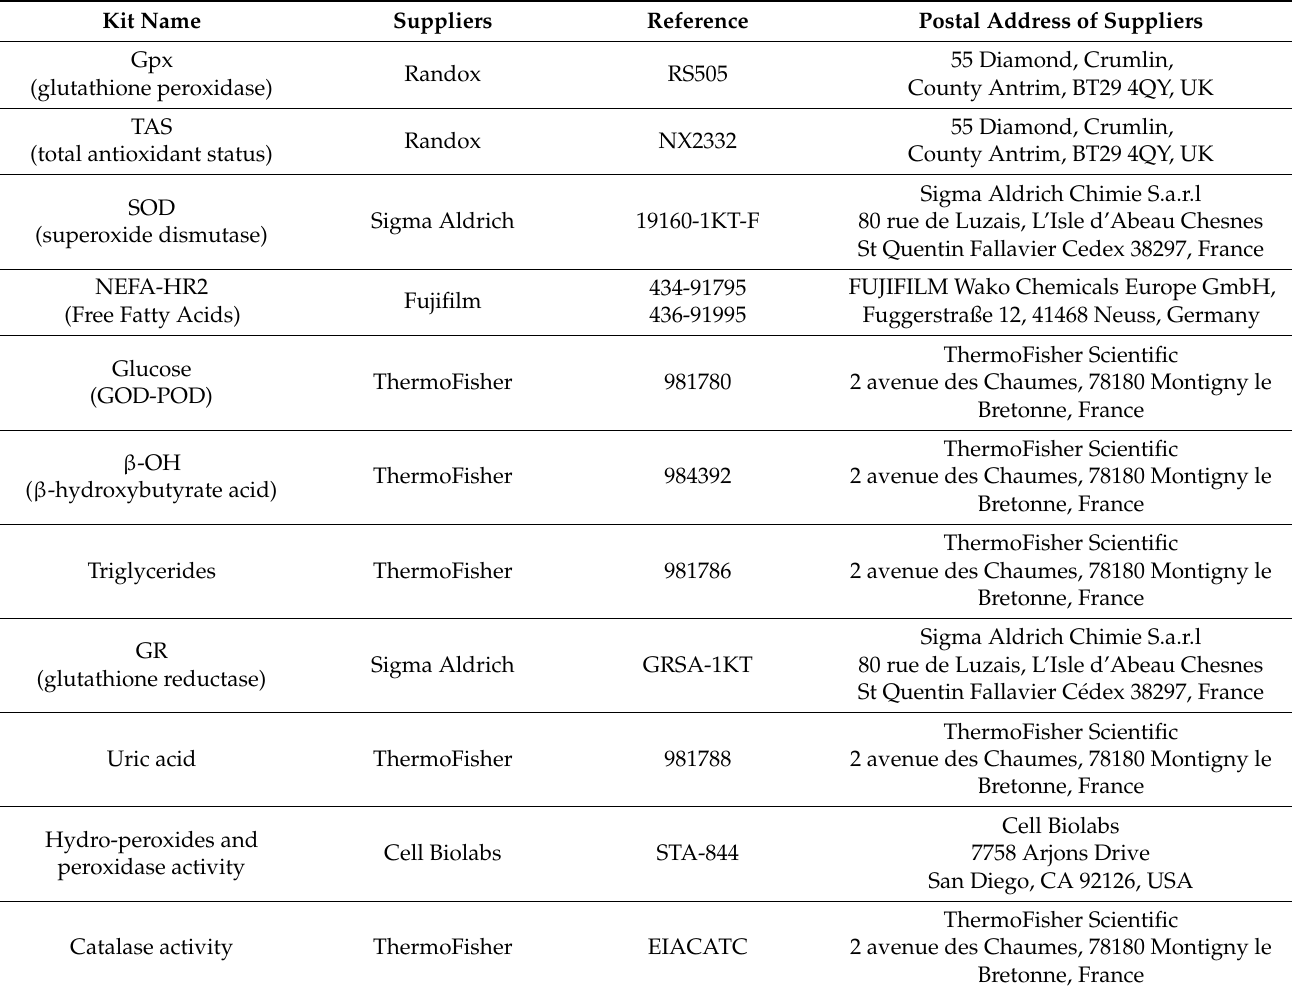
Table 2. List of kits used for the determination of the plasma metabolites and redox status of